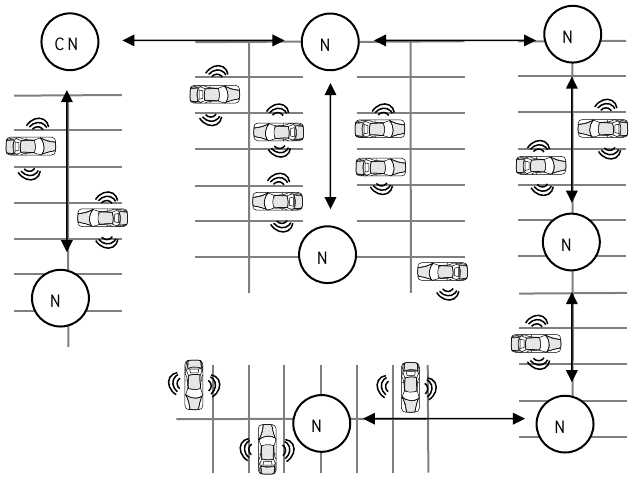
Figure 5. The overall structure of the smart parking system proposed in [30], where “N” and “CN” denote a node and a central node, respectively.